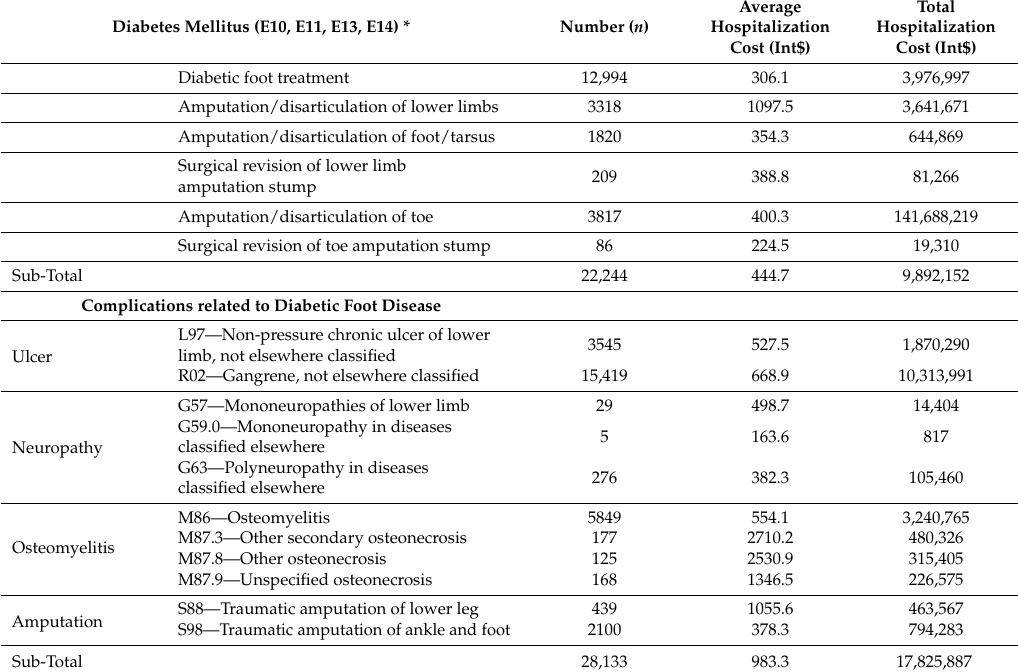
Table 5. Number, average cost and total costs of hospitalizations due to Diabetic Foot Disease. Brazil,